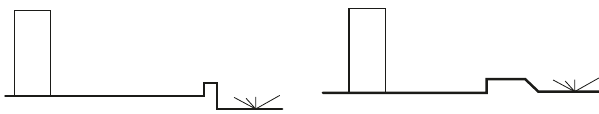
Figure 15: Landscape design for attenuating blast effect.